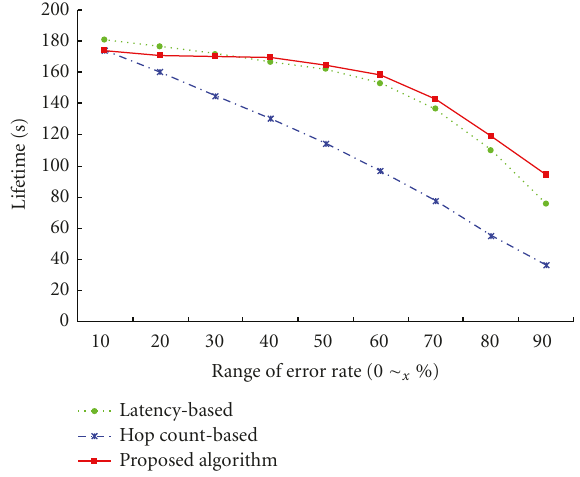
Figure 7: Network lifetime.